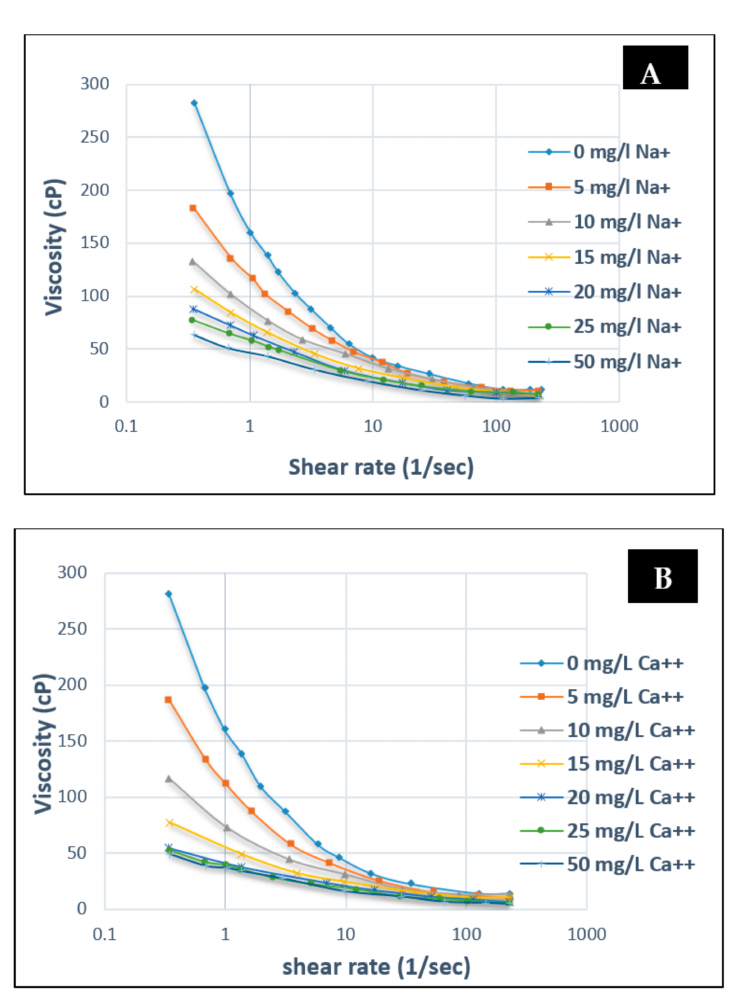
Figure 14. Influence of salinity ( A ) Na + on the viscosity of XG and ( B ) Ca 2 + on the viscosity of XG at di ff erent concentrations. Reprinted and modified from